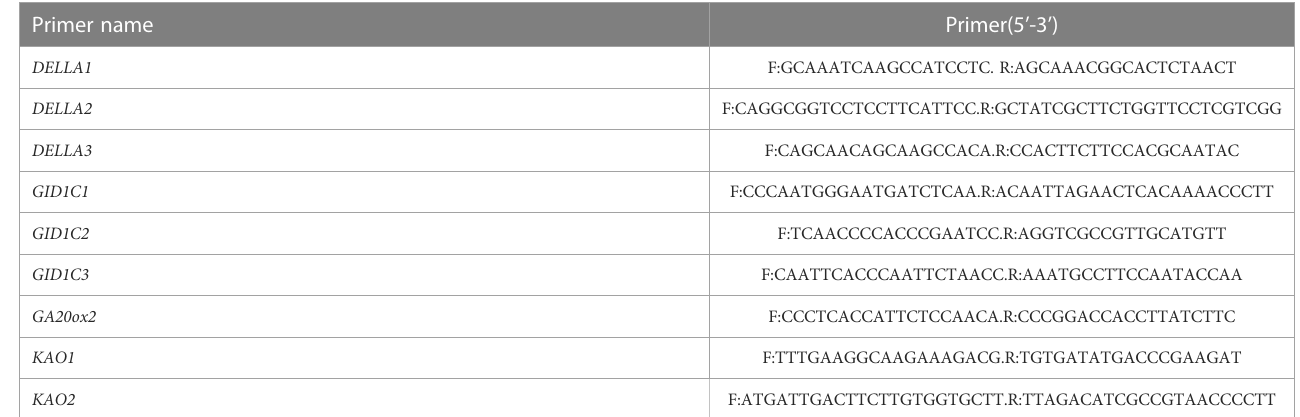
TABLE 2 Primers used real-time fl uorescence quantitative